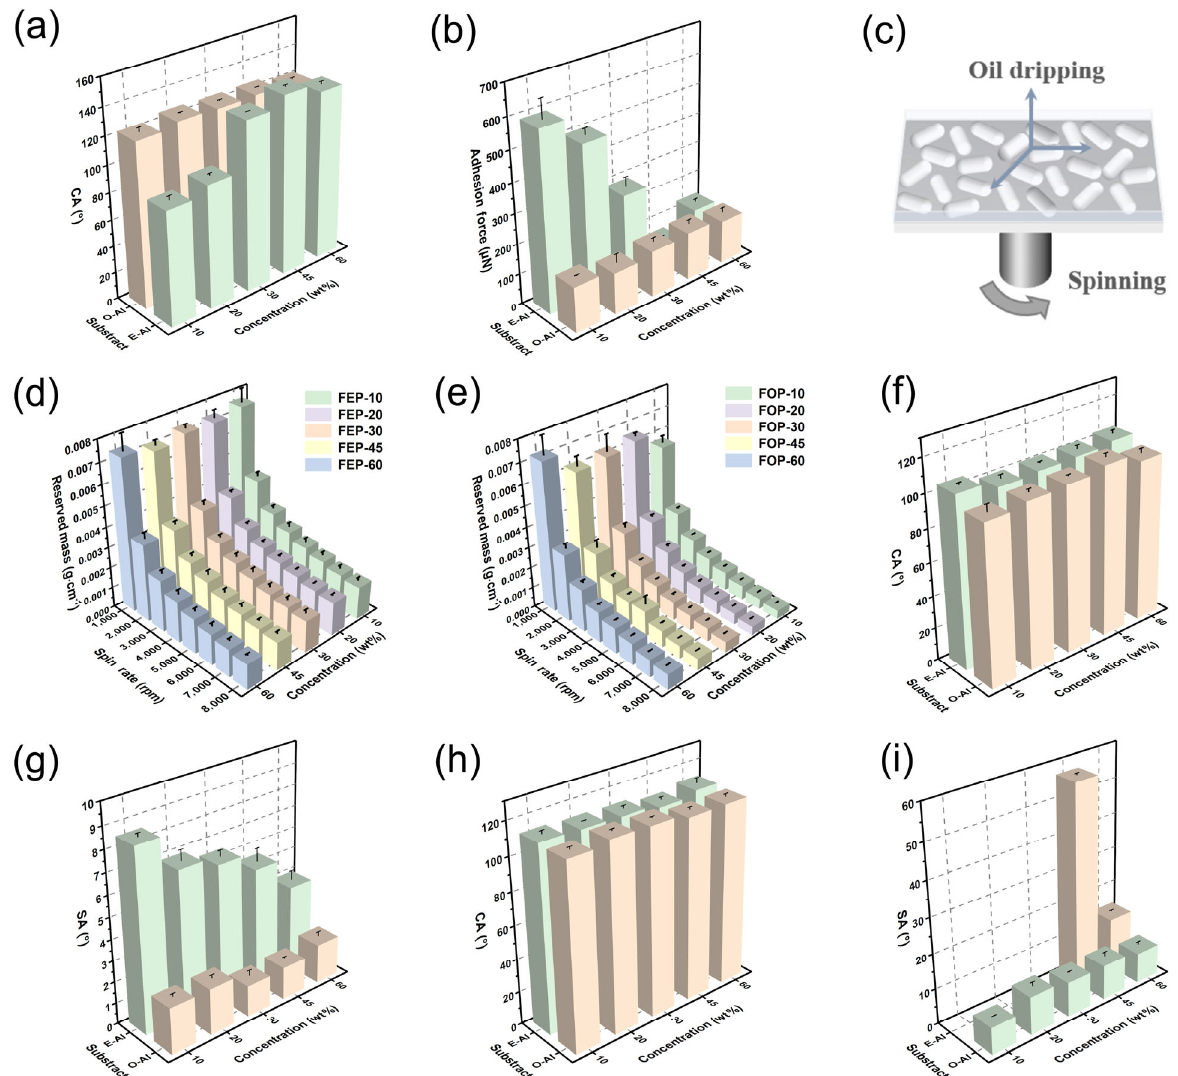
Fig. 2 Wettability and shear stability tests. (a) Water CAs of OP- x and EP- x . (b) Water adhesion force of OP- x and EP- x . (c) Diagram of the shear–spinning tests process. The reserved mass per unit area of lubricant of y -FOP- x (d) and y -FEP- x (e). Water CA (f) and SA (g) of FOP- x and FEP- x . Water CA (h) and SA (i) of 8000-FOP- x and 8000-FEP- x